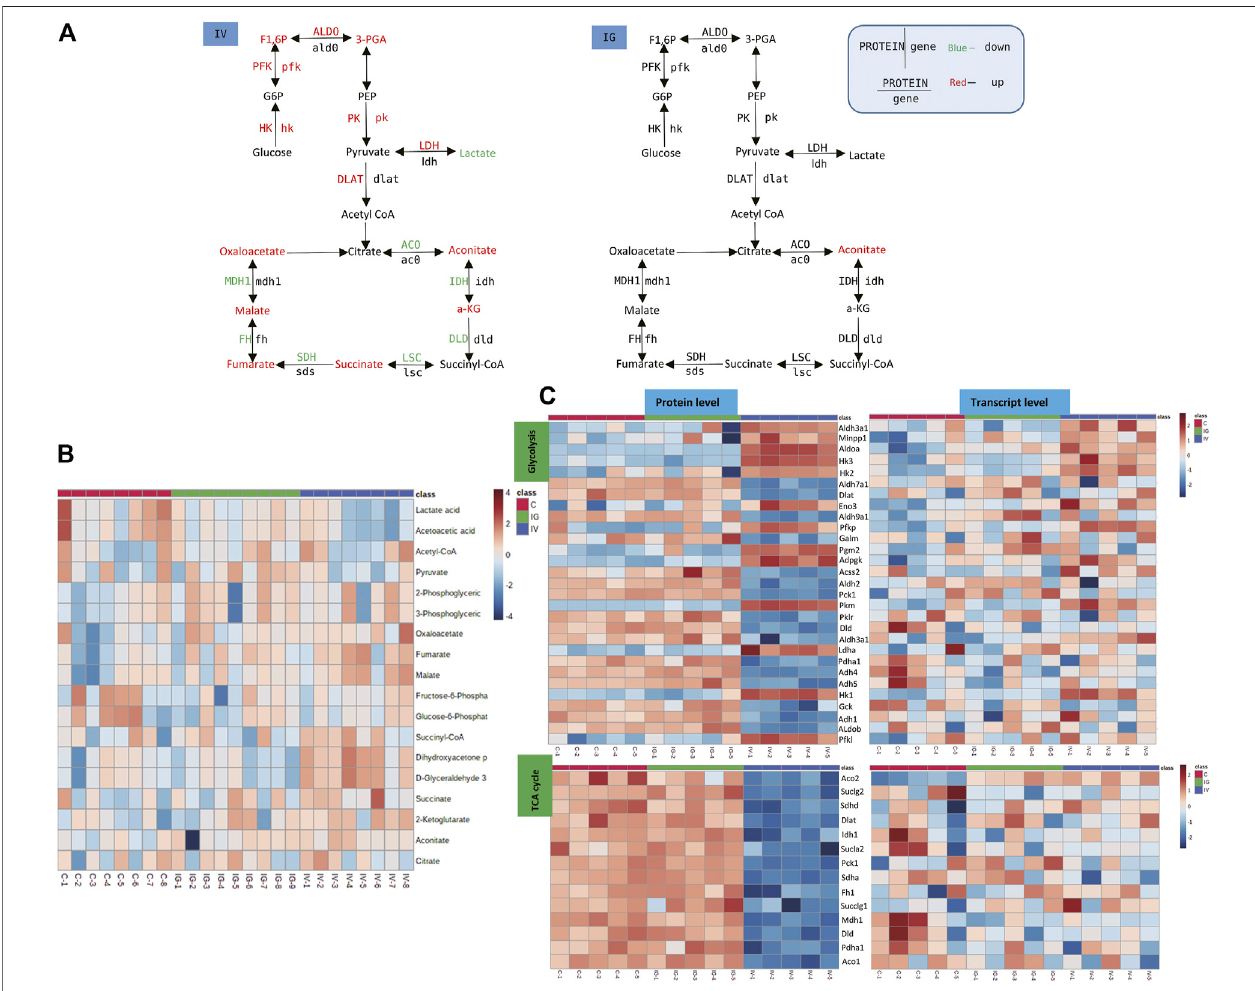
FIGURE 5 | Effect of Mesoporous Silica Nanoparticles (MSNs) on the TCA cycle in mitochondria and glycolysis based on different routes of administration (IV and IG). (A) Schematic of glycolysis and the TCA cycle pathway. Red indicates signi fi cant upregulation, and green indicates signi fi cant downregulation. (B) Heatmap of metabolite concentrations of glycolysis and the TCA cycle pathway. (C) Heatmaps of glycolysis and the TCA cycle pathway based on proteomics and transcriptomics.